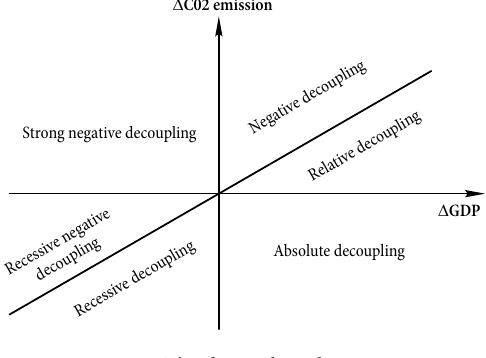
Fig. 1. The decoupling diagram